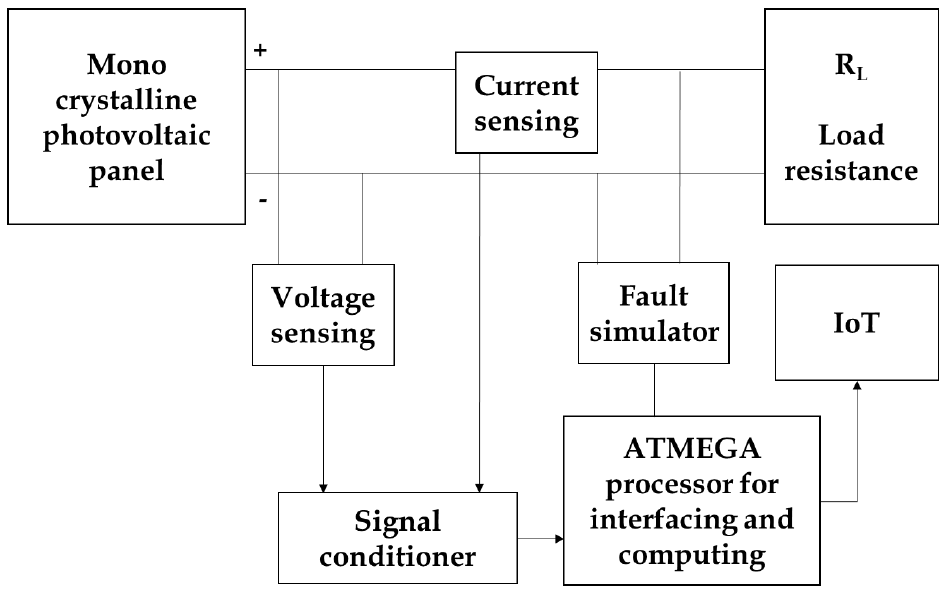
Figure 4. Proposed experimental work for fault diagnosis in PV panel.